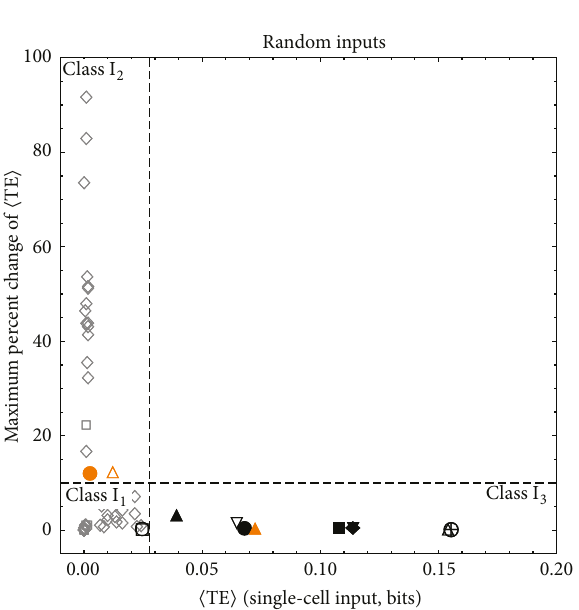
Figure 3: Maximum percent change of ⟨ TE ⟩ as a function of ⟨ TE ⟩ 1 (3). Equivalent rules are represented by a single marker, colored as in Figure 2 but with Wolfram Classes I and II in gray. Rules above the horizontal dashed line can undergo a change of at least one order of magnitude in ⟨ TE ⟩ . The vertical dashed line is the same as in Figure 2(a).